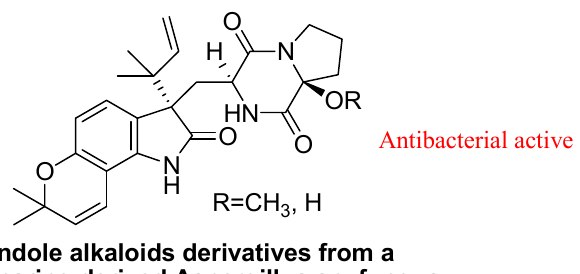
Figure 19. Indoles isolated from marine fungus